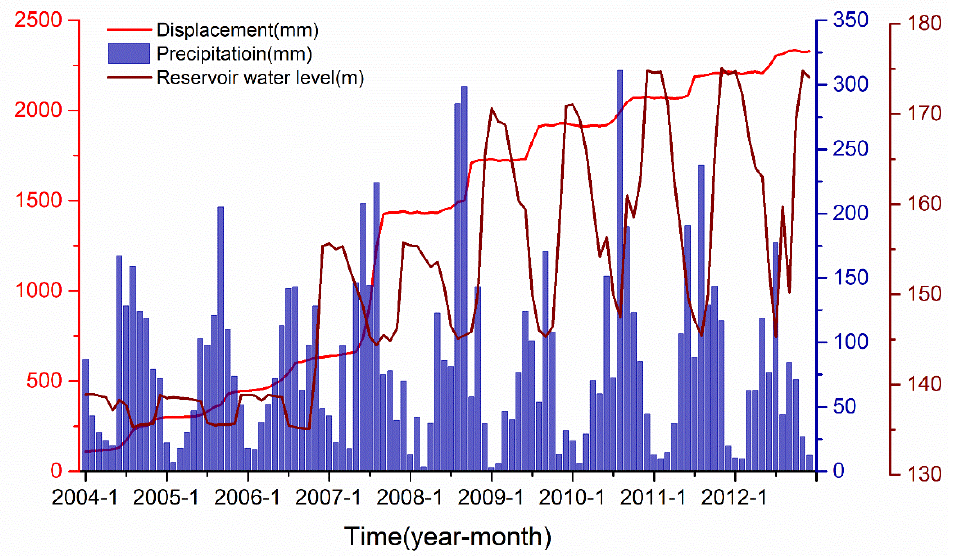
Figure 5. The variations in the displacement, rainfall, and reservoir water level of the Baishuihe landslide area.